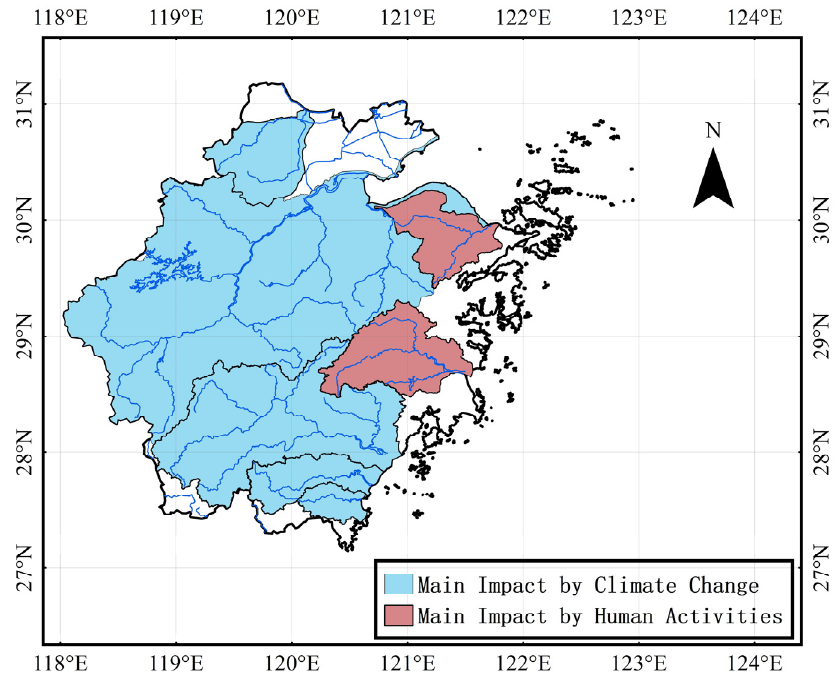
Figure 11. Map of the dominant distribution of annual streamflow in each river system by human activities and climate change.